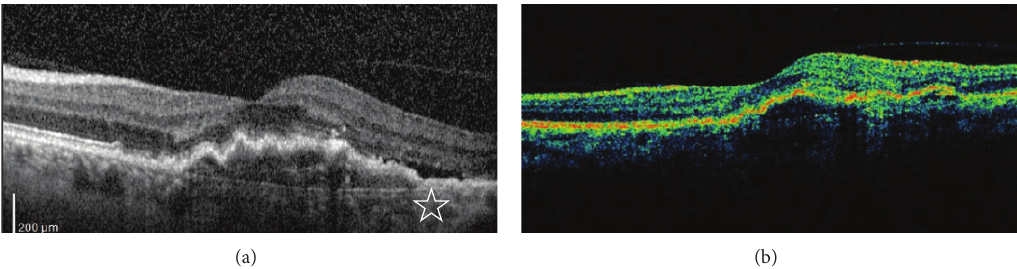
Figure 1: Spectral-domain optical coherence tomography (a) and time-domain optical coherence tomography (b) scans of a patient; the white star shows the subretinal fluid on spectral-domain optical coherence tomography.